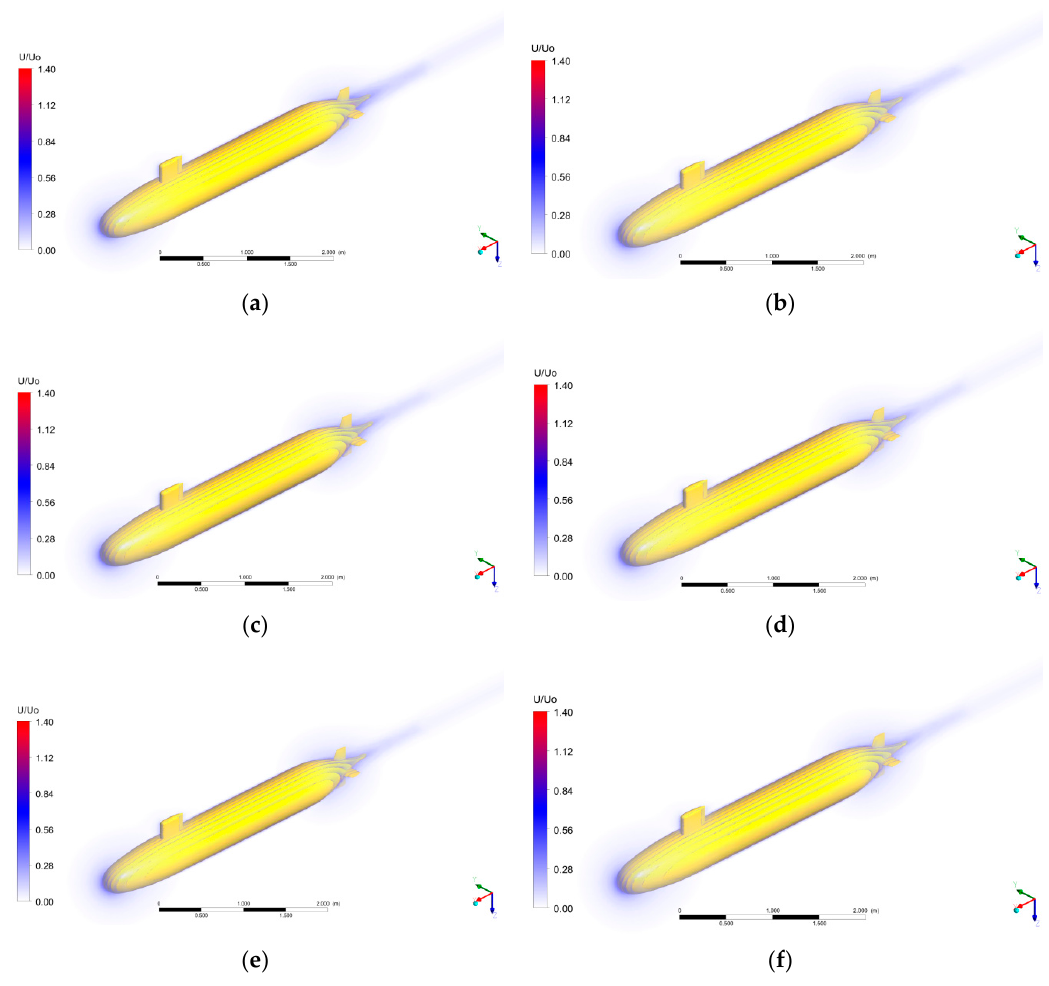
Figure 8. Normalized velocity contours around the SUBOFF model under towing speeds of ( a ) 3.05 m/s; ( b ) 5.144 m/s; ( c ) 6.096 m/s; ( d ) 7.16 m/s; ( e ) 8.23 m/s; and ( f ) 9.151 m/s at t = 30 s.